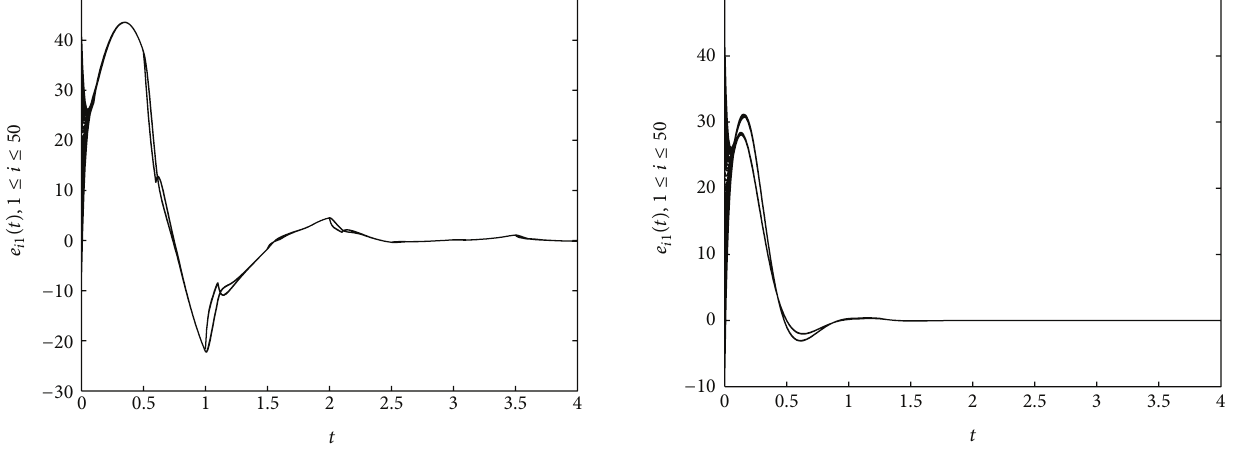
Figure 11: Synchronization errors 𝑒 𝑖 1 , 1 ≤ 𝑖 ≤ 50, with full control parameters 𝑘 = 5, 𝑇 = 0 . 5, and 𝜃 = 1.